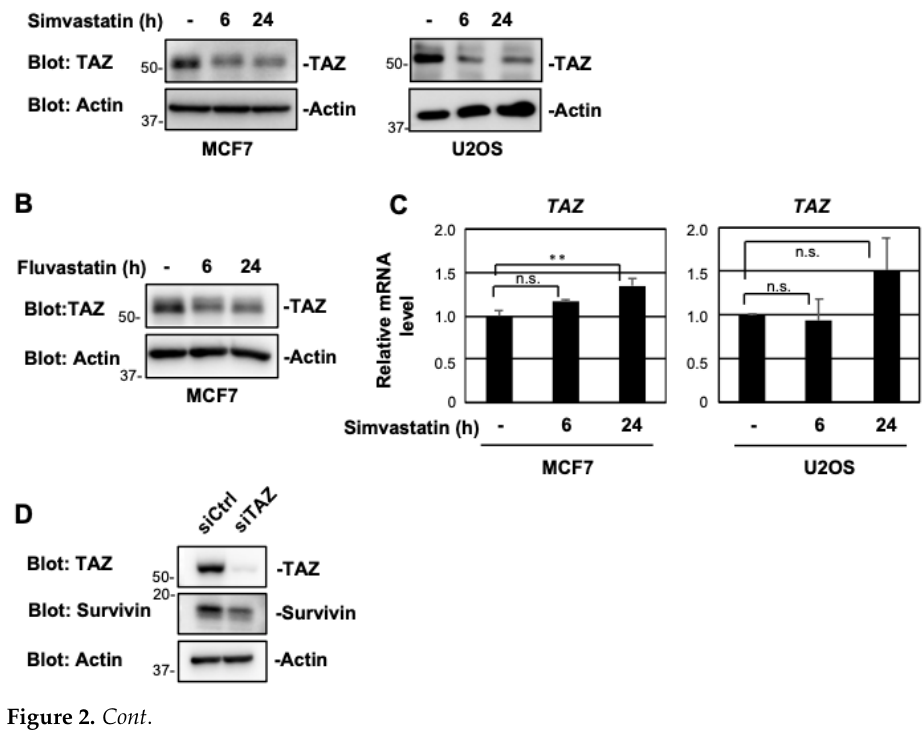
Figure 2. Simvastatin and fluvastatin suppress TAZ protein expression. ( A ) MCF7 and U2OS cells were treated with 10 μM simvastatin for the indicated times. Cell lysates were immunoblotted with the indicated antibodies. ( B ) MCF7 cells were treated with 10 μM fluvastatin for the indicated times. Cell lysates were then analyzed as in ( A ). ( C ) Cells were treated with 10 μM simvastatin and the expression of each gene was assessed by RT-qPCR. The expression levels of TAZ were normalized against the expression level of β -actin mRNA. Results are shown as the mean ± S.D. ( n = 3). ( D ) MCF7 cells were transfected with control or TAZ siRNA. After 48 h, cell lysates were immunoblotted with the indicated antibodies. ( E ) MCF7 cells were treated with 10 μM simvastatin and the expression of each gene was assessed by RT-qPCR. The expression levels of survivin were normalized using the expression level of β -actin mRNA. Data represent the mean ± S.D. ( n = 3). ( F ) MCF7 cells were treated with 10 μM simvastatin for 24 h. Cell lysates were then analyzed by Western blotting with the indi- cated antibodies. Significant differences are indicated as ** p < 0.01. 2.2. Simvastatin Enhances p53 Target Gene Expression We previously reported that TAZ suppressed the transcriptional activation ability of p53 [15]. Since simvastatin suppressed TAZ protein expression, we examined whether simvastatin affected the transcriptional activity of p53. In the absence of stress, p53 binds to the ubiquitin ligase Mdm2 and undergoes degradation. Nutlin-3 (Figure 1C), an inhib- itor of Mdm2, activates p53 by dissociating it from Mdm2 [25]. We treated MCF7 and U2OS cells expressing WT p53 with nutlin-3 or simvastatin. As shown in Figure 3A, the protein expression of p21, a target gene of p53, was increased by the stimulation with simvastatin (lane 3) or nutlin-3 (lane 2). Furthermore, the co-treatment with nutlin-3 and simvastatin increased the expression of p21 significantly more than the single treatment